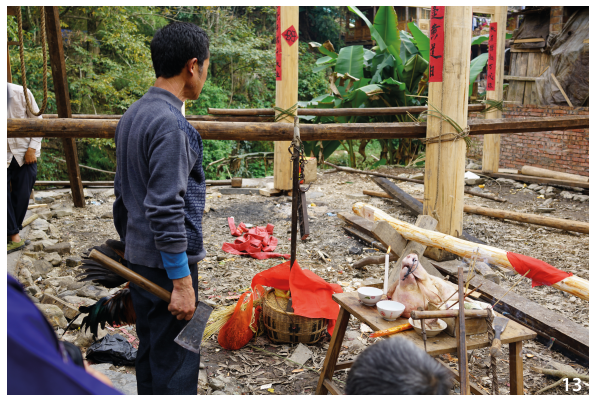
Figure 13 The beginning of shangliang ritual. Dali Village, 2016 (Source: Congcong